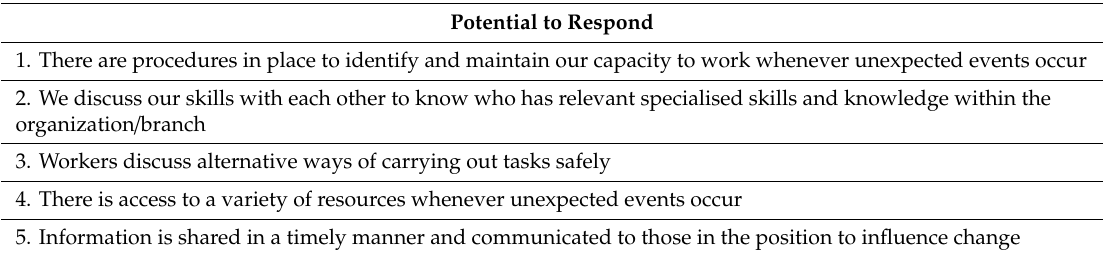
Table 1. Potential to Respond survey questions.